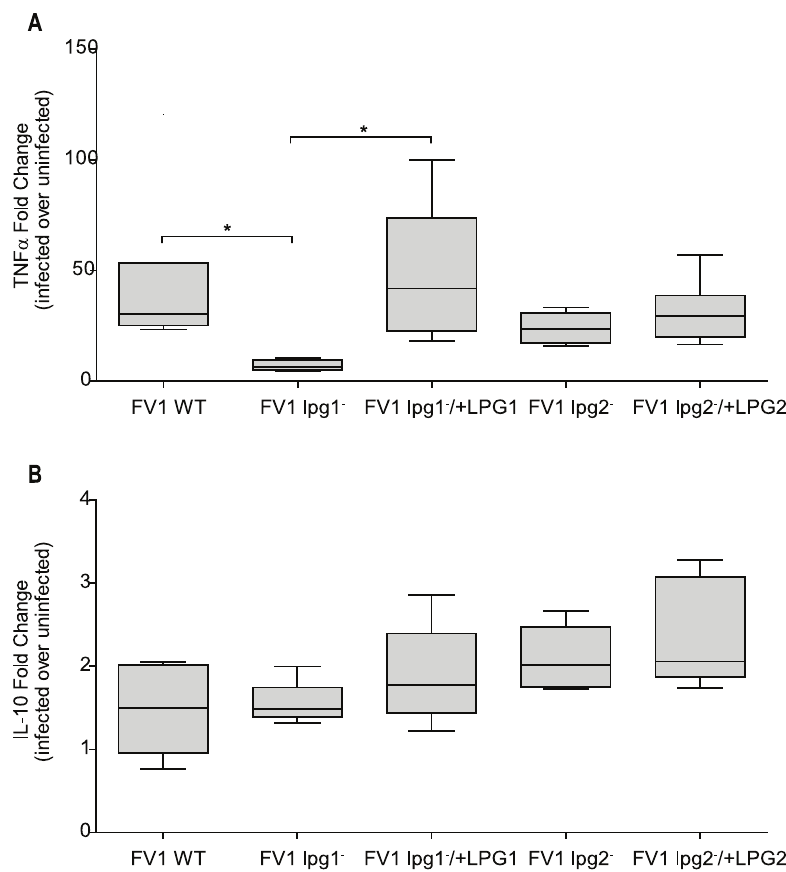
Fig 4. Relative TNF and IL10 levels in L . major Friedlin V1 infected DCs. Human DCs were infected with L . major FV1 parasites: L . major FV1 (WT) , LPG null mutant (FV1 lpg1 − ), LPG add back (FV1 lpg1 − /+ LPG1 ), PG null mutant (FV1 lpg2 − ), or PG add back (FV1 lpg2 − /+ LPG2 ). At 8 hrs post infection, ( A ) TNF (n = 5 donors) and ( B ) IL10 (n = 5 donors) expression was measured by qRT-PCR. Fold changes were calculated using the ΔΔ C T method and are represented as fold change over uninfected samples. Box plots display the median value (line), the interquartile range (box), and Tukey whiskers encompassing data within 1.5 fold of the interquartile range; data outside this range are presented as individual data points (open circles). * Statistical significance (p < 0.05). All values were significantly greater than